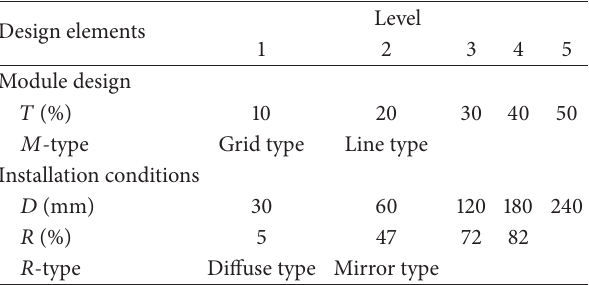
Table 1: Design elements for the bifacial BIPV module. Design